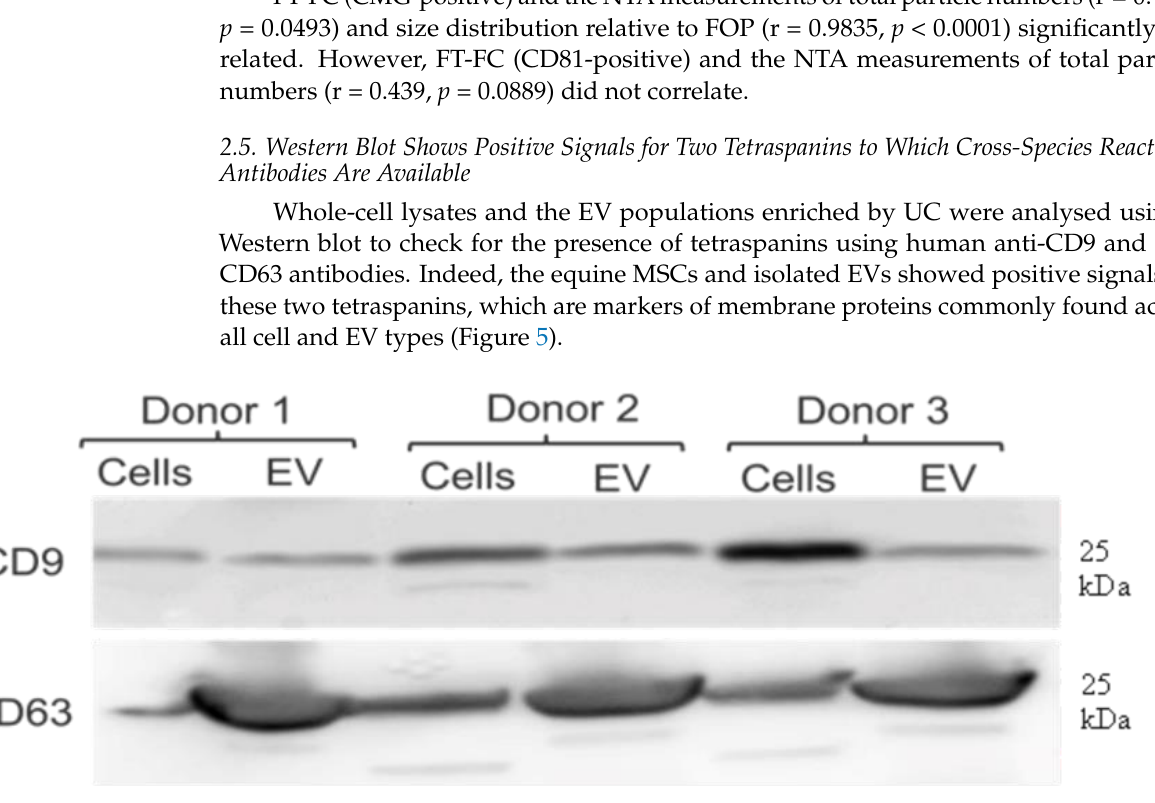
Figure 5. Western blot of equine MSC cell isolates and UC isolated EVs: All isolates from all donors were positive for CD9 and CD63 in the whole-cell lysates and their respective EV isolates.